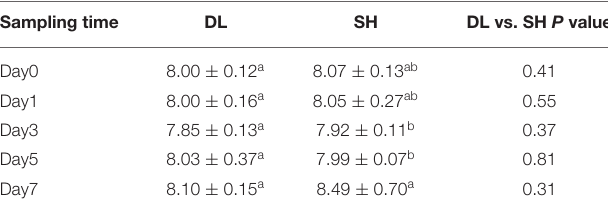
TABLE 2 | Effects of bicarbonate AW (NaHCO 3 ) stress on the blood pH ( n = 9) in DL (the alkali form introduced from Lake Dali Nor) and SH (the freshwater form introduced from Songhua River) fish